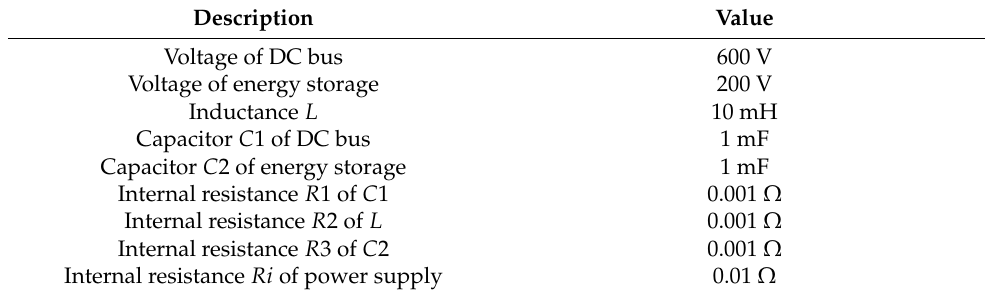
Table 1. Circuit